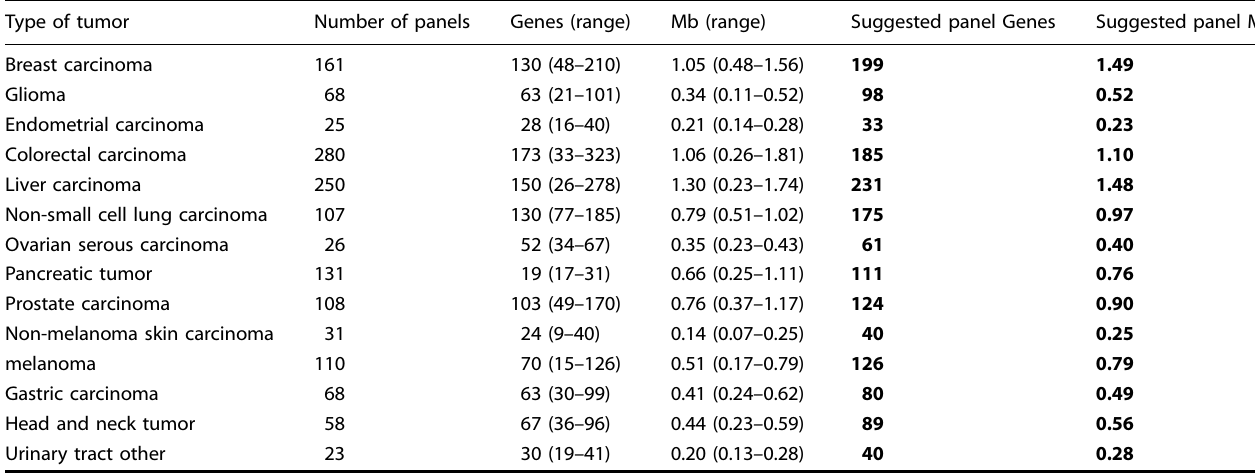
0.100.250.501.001.50